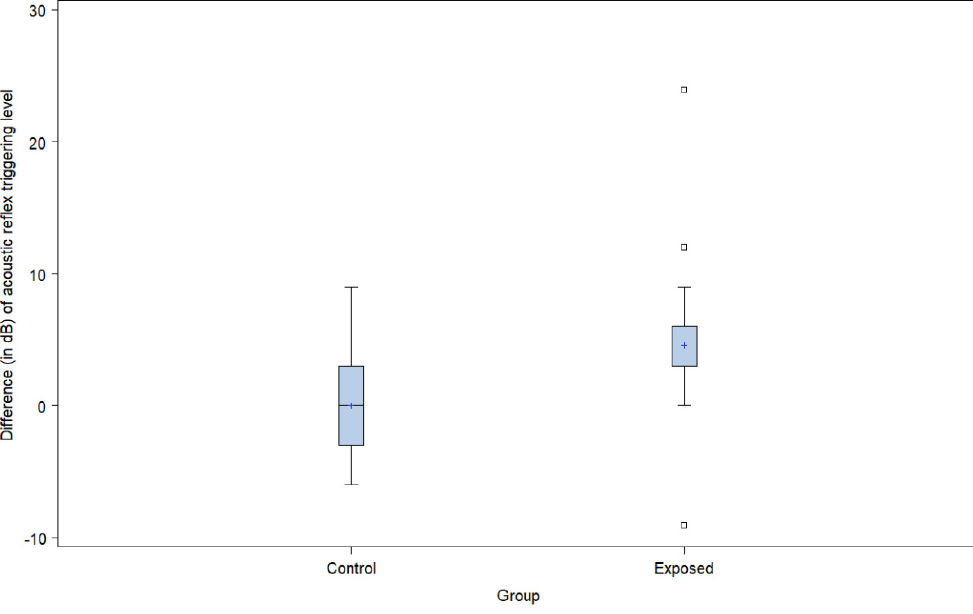
Figure 4. Boxplot of the difference (in dB) of acoustic reflex triggering levels before and after the participant’s work shift, by exposure group.